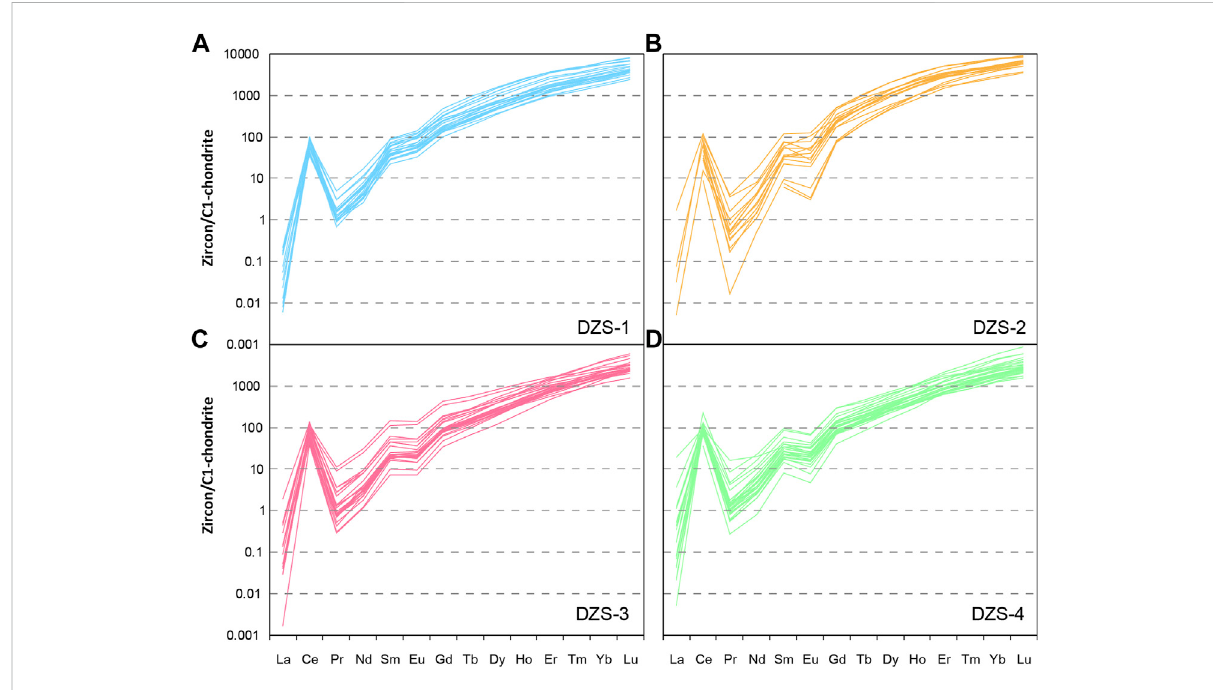
FIGURE 8 Zircon REE concentrations of quartz porphyry, Linglong granite, rhyolite porphyry, and Dazeshan biotite granite, respectively (A – D) . The normalization values are from Sun and McDonough